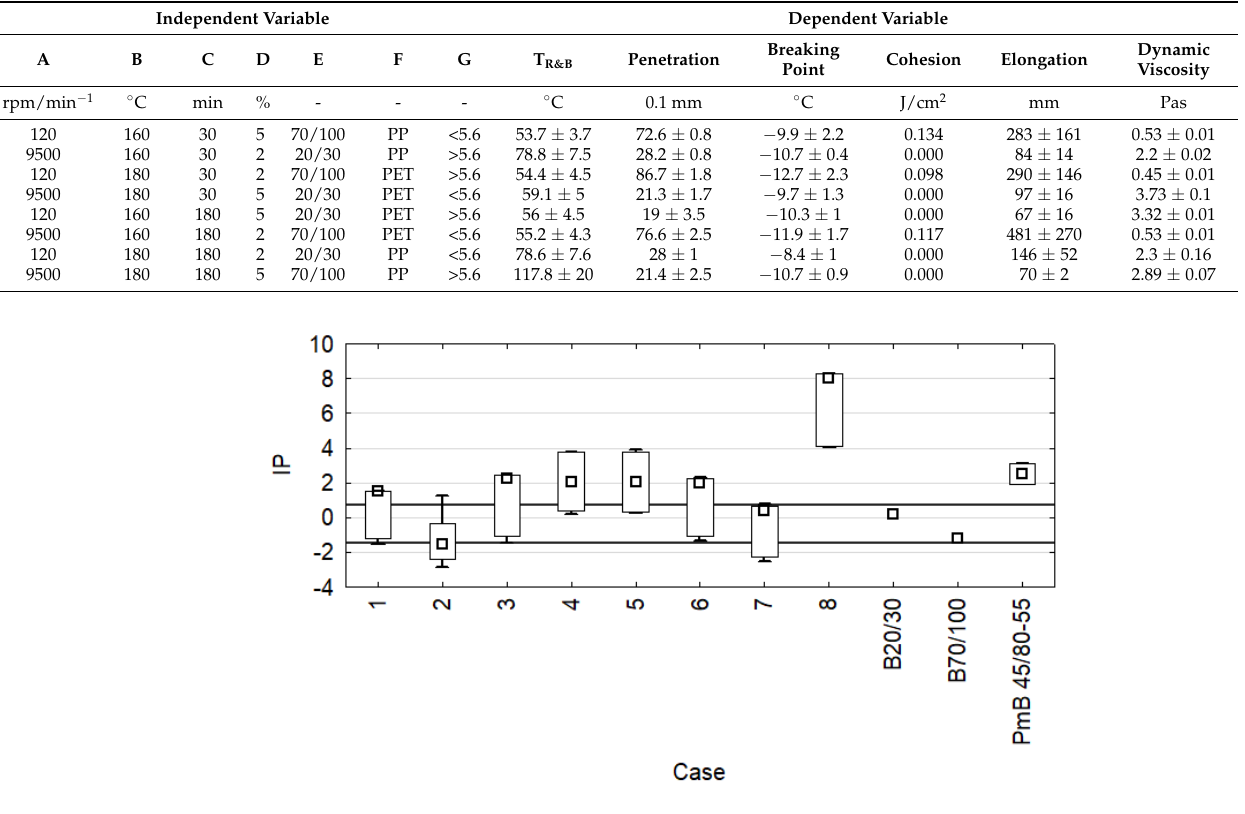
Figure 4. Designated penetration index values.